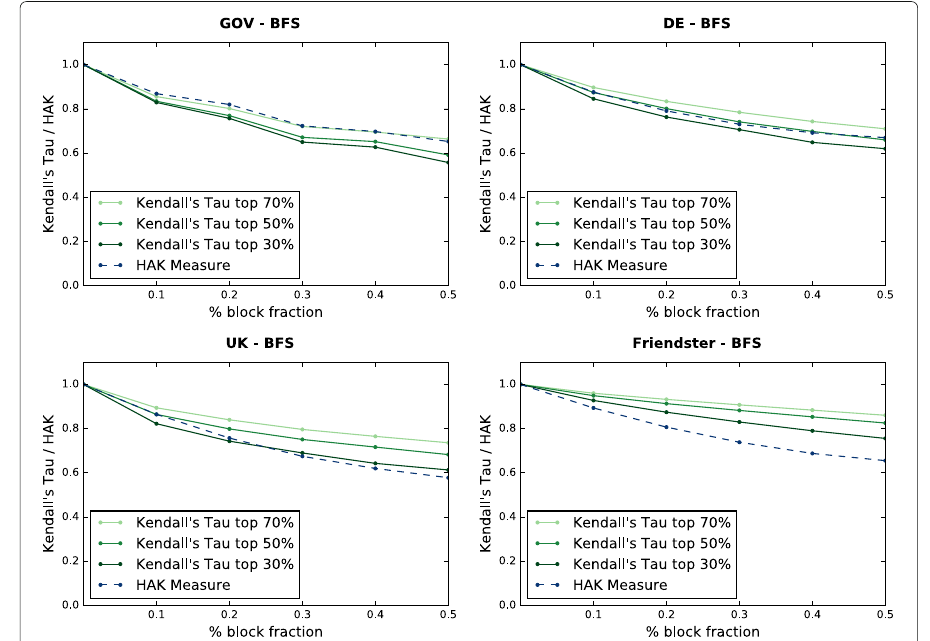
Fig. 3 Ranking deviations measured and estimated for real-world graphs and crawls for different fractions of uncrawled